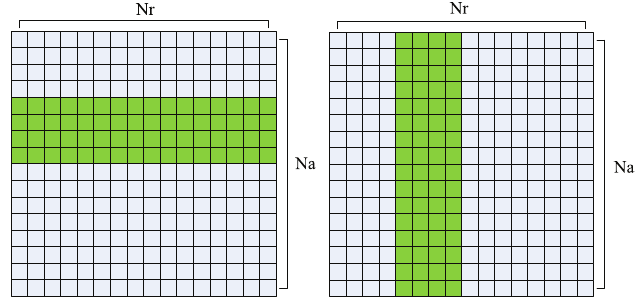
Figure 6. Data distribution in range ( Left ) and azimuth ( Right